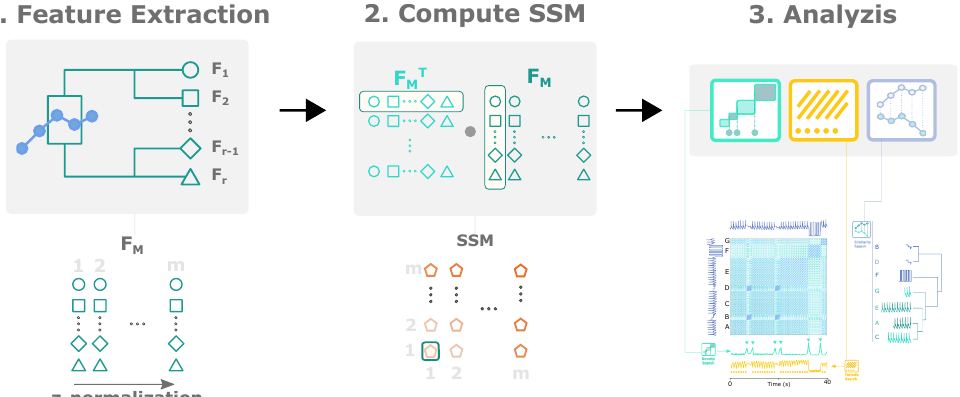
Figure 3. A step-by-step flowchart for calculating and analysing the SSM. The signal-based calculation requires input parameters of the window size w and the overlapping percentage o to fulfil the first- stage feature extraction. Features are extracted on each subsequence ( sT 1 , sT 2 , . . . , sT N ) , where N is the total number of windows. K features are extracted from window i ( sT i : f i Different features are associated with different shapes ( (cid:13) , (cid:3) , ♦ and (cid:52) ) in the figures. The features can be extracted on an M -variable record and each feature is positioned as a row on the F M for the SSM